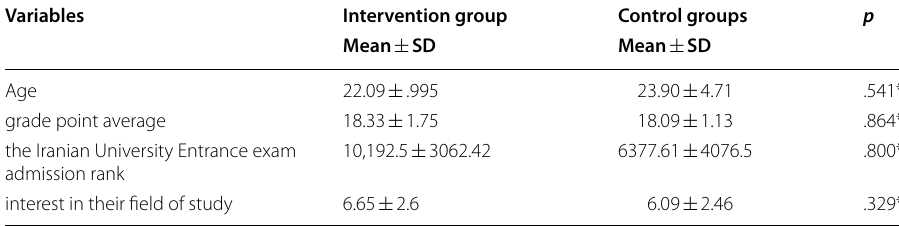
Table 1 Demographic characteristics in two groups of intervention and